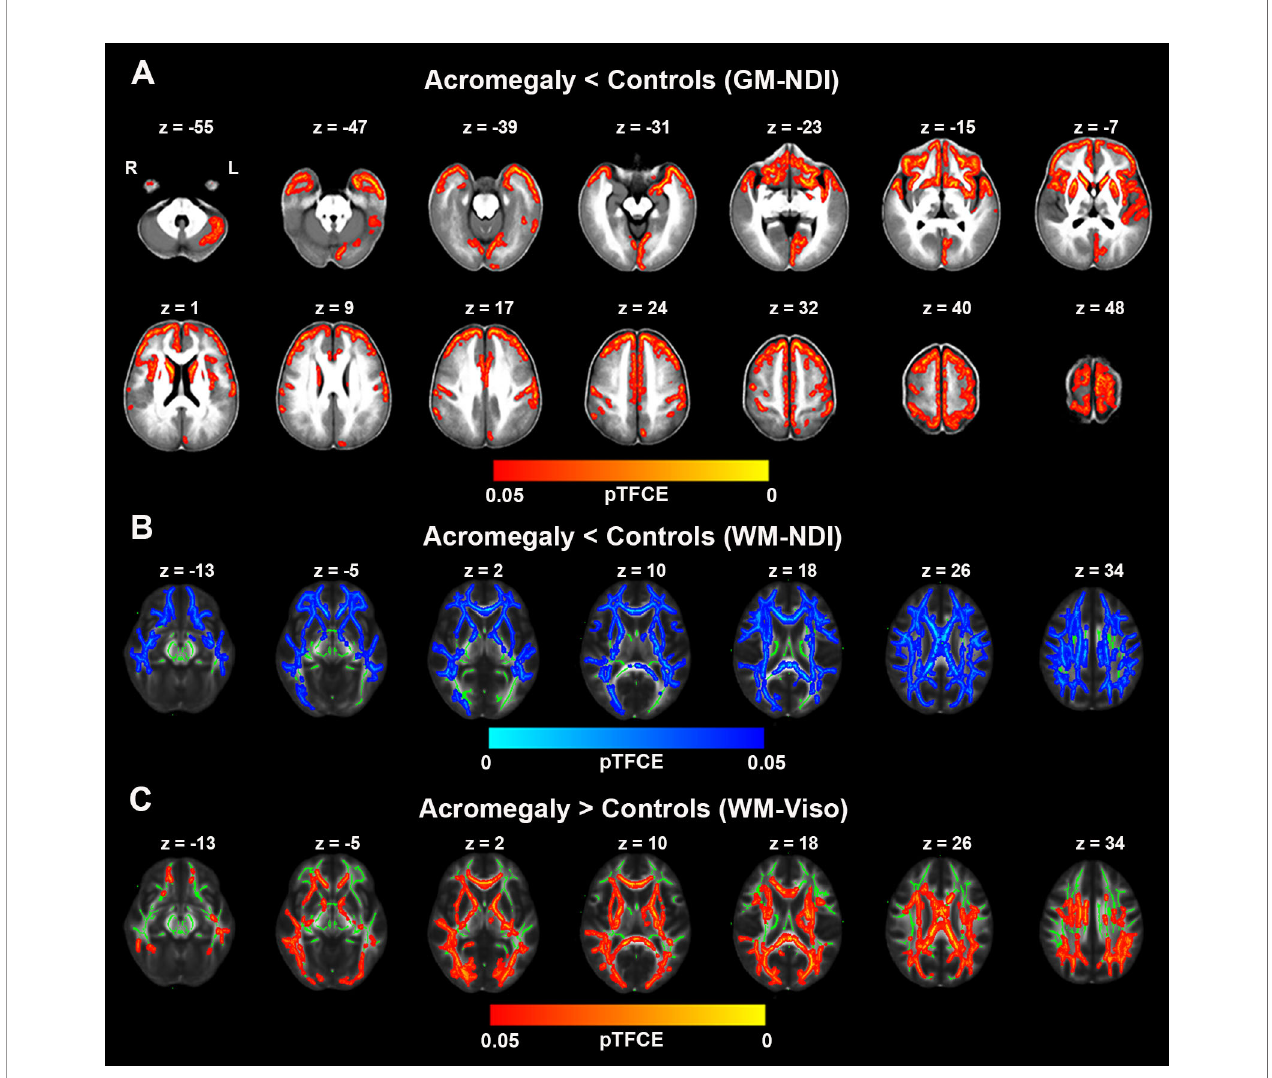
FIGURE 3 | Microstructural pathological alterations in NODDI metrics in cortex and white matter in acromegaly. (A) showed lower neuritic density index (NDI) in acromegaly relative to controls (Red-yellow, pTFCE < 0.05) in gray matter – based spatial statistics (GBSS). (B) showed signi fi cant reductions in NDI across the whole brain white matter in acromegaly compared to controls (Blue, pTFCE < 0.05) in tract – based spatial statistics (TBSS). (C) showed signi fi cant increases in Viso across the whole brain white matter in acromegaly compared to controls (Red-yellow, pTFCE < 0.05) in tract – based spatial statistics (TBSS). GM, grey matter; WM, white